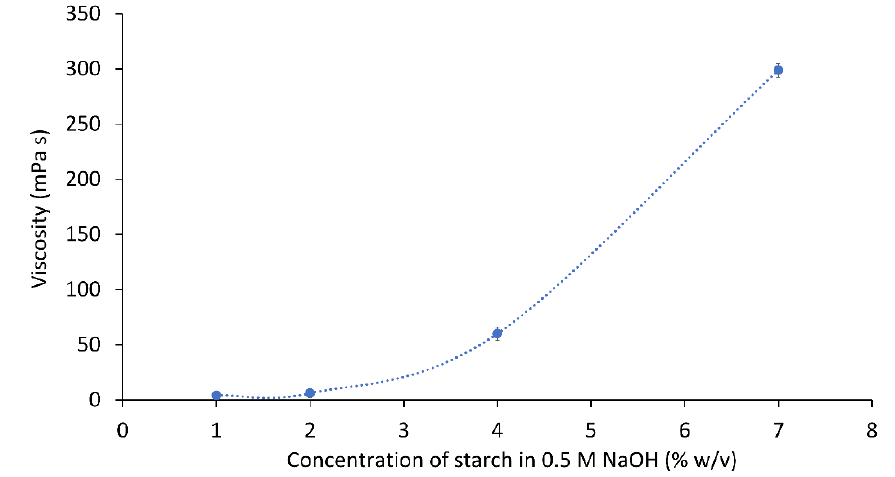
ff ect of starch concentration on zero shear Figure 3. Effect of starch concentration on zero shear viscosity. Figure 3. E Figure 3. Effect of starch concentration on zero shear viscosity.